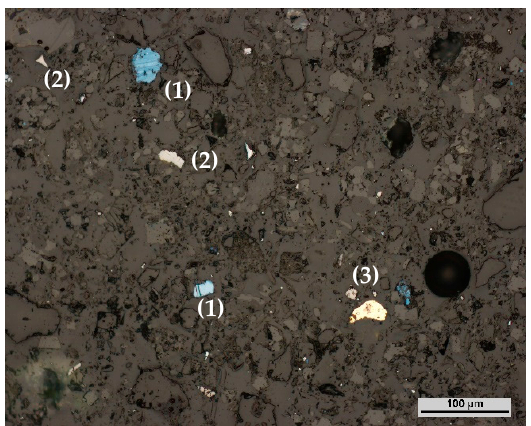
Figure 7. F sp = 4 N/mm 2 : liberated particles of covellite (1), chalcocite (2) and chalcopyrite (3).